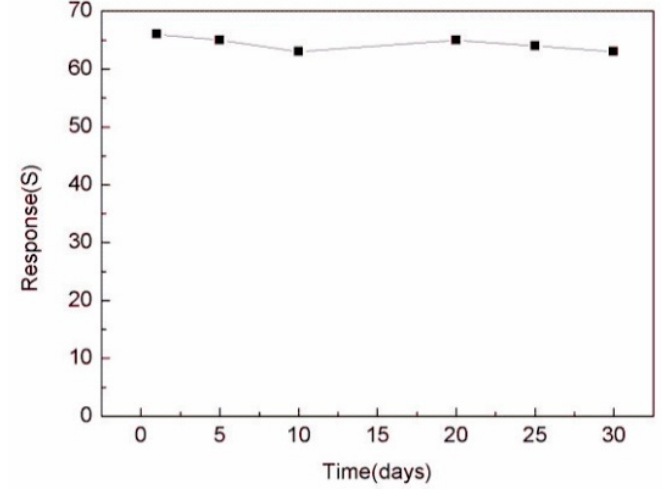
Figure 10. The stability of the In 2 O 3 -8 h sensor was tested for the duration of one month.